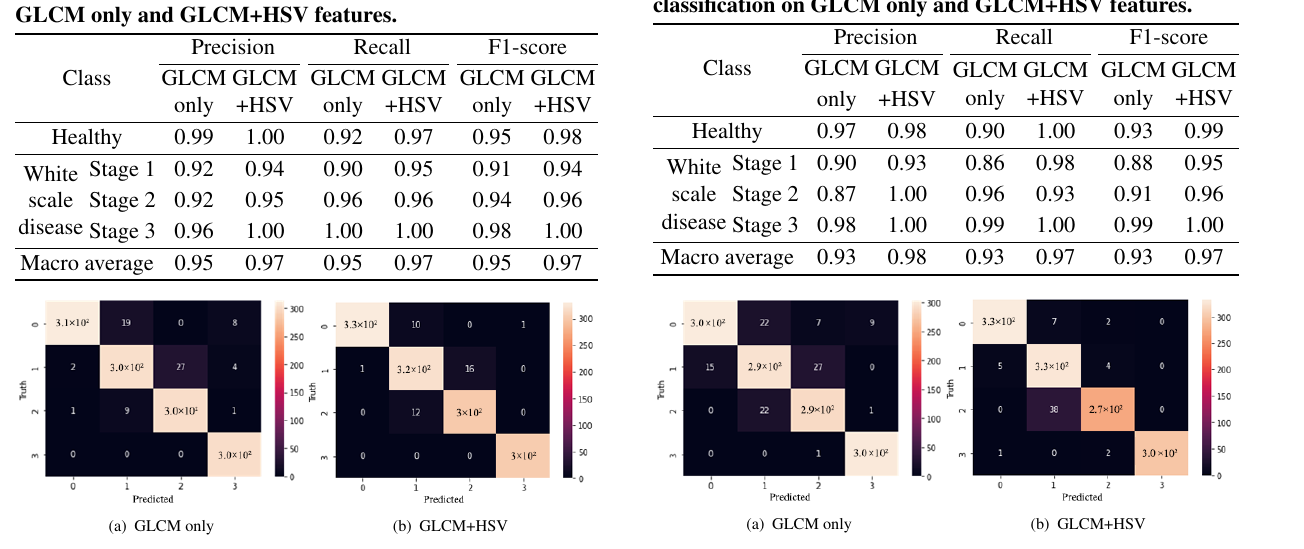
Fig. 7 Confusion matrices of KNN classifier.